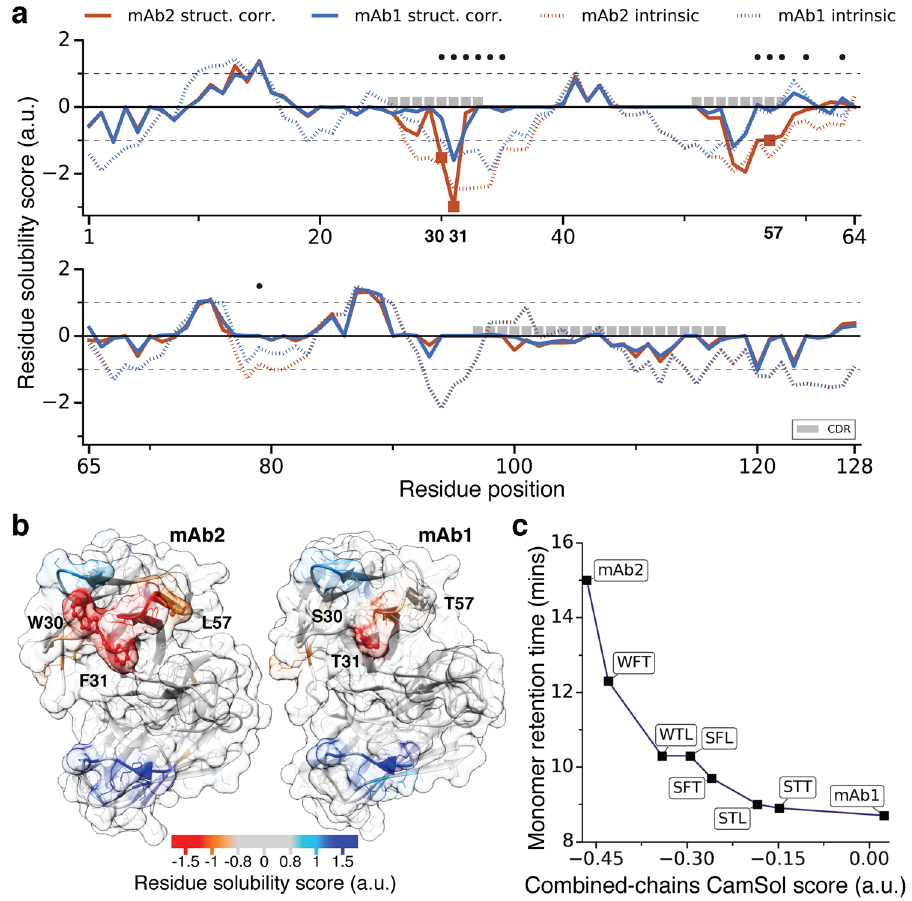
Figure 5. Aggregation hot-spot analysis and validation on mutational variants or mAb2. ( a ) Structurally- corrected (solid lines) and intrinsic (broken lines) CamSol solubility profiles for the VH domain of mAb1 (blue) and mAb2 (red). Residue positions at which the two sequences are different are labelled with a black dot above the profiles, CDR positions (IMGT annotation) with grey boxes. Square markers on the structurally corrected profile denote the positions on mAb2 ( W30, F31, L57 ) that have been experimentally identified as aggregation hot-spots 20 . ( b ) The structurally corrected solubility profile is color-coded on the surface of homology models (built with SabPred 36 ) of the VH/VL domains of mAb2 (left) and mAb1 (right). Aggregation-promoting regions are in orange/red while aggregation-protecting ones in light blue/blue. The experimentally-identified self- association hotspots on mAb2 and the corresponding residues on mAb1 are labelled and represented as balls- and-sticks. ( c ) Measured HP-SEC monomer retention time 20 for various mAb variants as a function of their combined-chain solubility score calculated from the sequence alone. mAb2 has the residue types W, F , and L at the hot-spot positions 30, 31 and 57 respectively, while mAb1 has S, T , and T . The six variants between mAb2 and mAb1 are named according to which mAb2 position(s) have been mutated to the corresponding mAb1 amino acid 20 (e.g. WFT is mAb2 L57T). The line is a guide for the